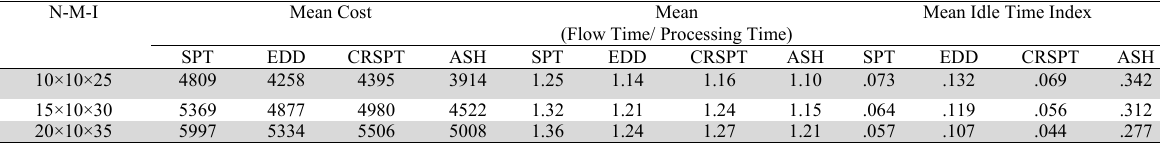
Comparison of applying randomization procedure in ASH with other scheduling rules N-M-I Mean